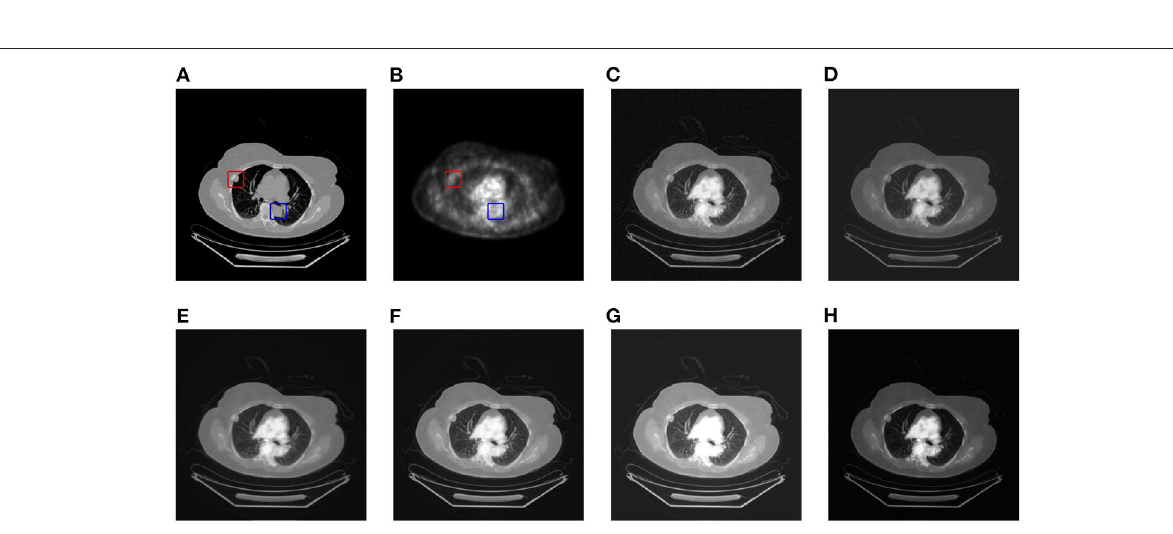
FIGURE 4 | The qualitative comparison results of patient A. (A) CT; (B) PET; (C) AD; (D) GF; (E) PAPCNN; (F) MCFNET; (G) IFCNN; (H) OURS.